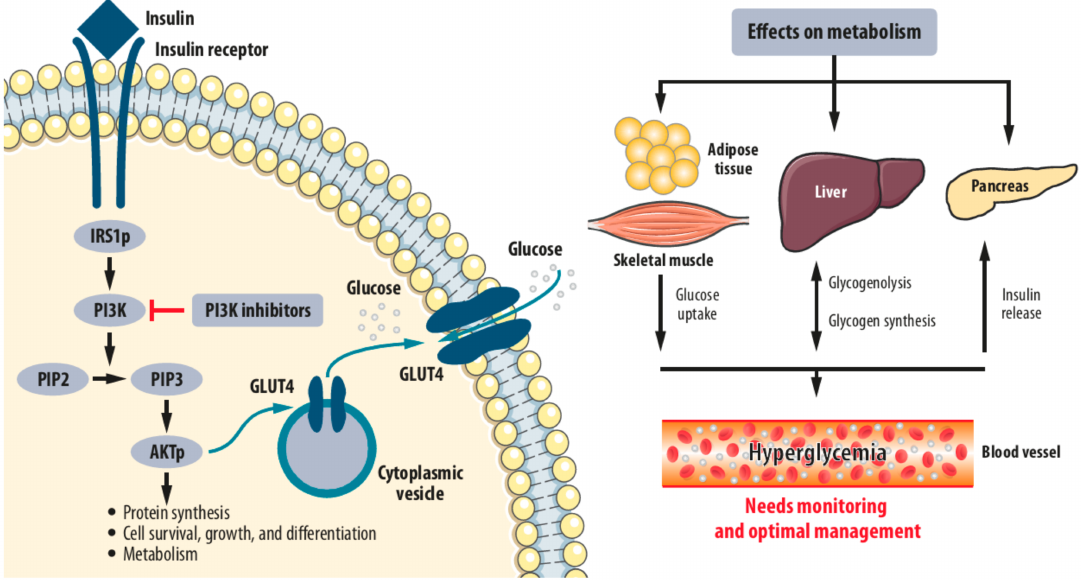
Figure 1. PI3K inhibitors prevent the conversion of PIP2 to PIP3 and the activation of AKT through phosphorylation by PIP3. Blockade of the metabolic effects of AKT leads to (1) transient insulin resis- tance due to lack of translocation of the glucose transporter GLU4 from cytoplasmic vesicles to the cell membrane, and therefore lack of passage of glucose molecules into the liver, fat, and muscle cells, as well as (2) increased glycogenolysis in the liver. In turn, both (1) and (2) lead to hyperglycemia, as well as increased insulin release by the pancreas with ensuing hyperinsulinemia. AKT, protein kinase B; GLU4, glucose transporter 4; IRS1p, insulin receptor substrate 1, phosphorylated; PI3K, phos- phatidylinositol 3-kinase PIP2, phosphatidylinositol 4,5-bisphosphate; PIP3, phosphatidylinositol